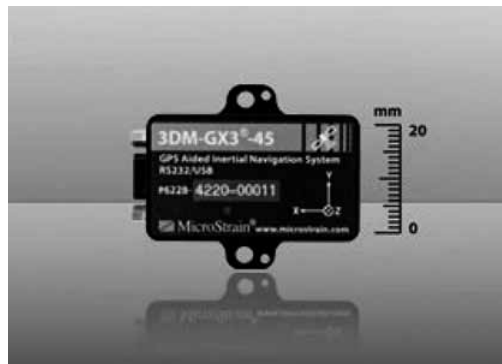
Fig. 3. 3DM-GX3-45-miniature-GPS-aided-inertial-navi ga-